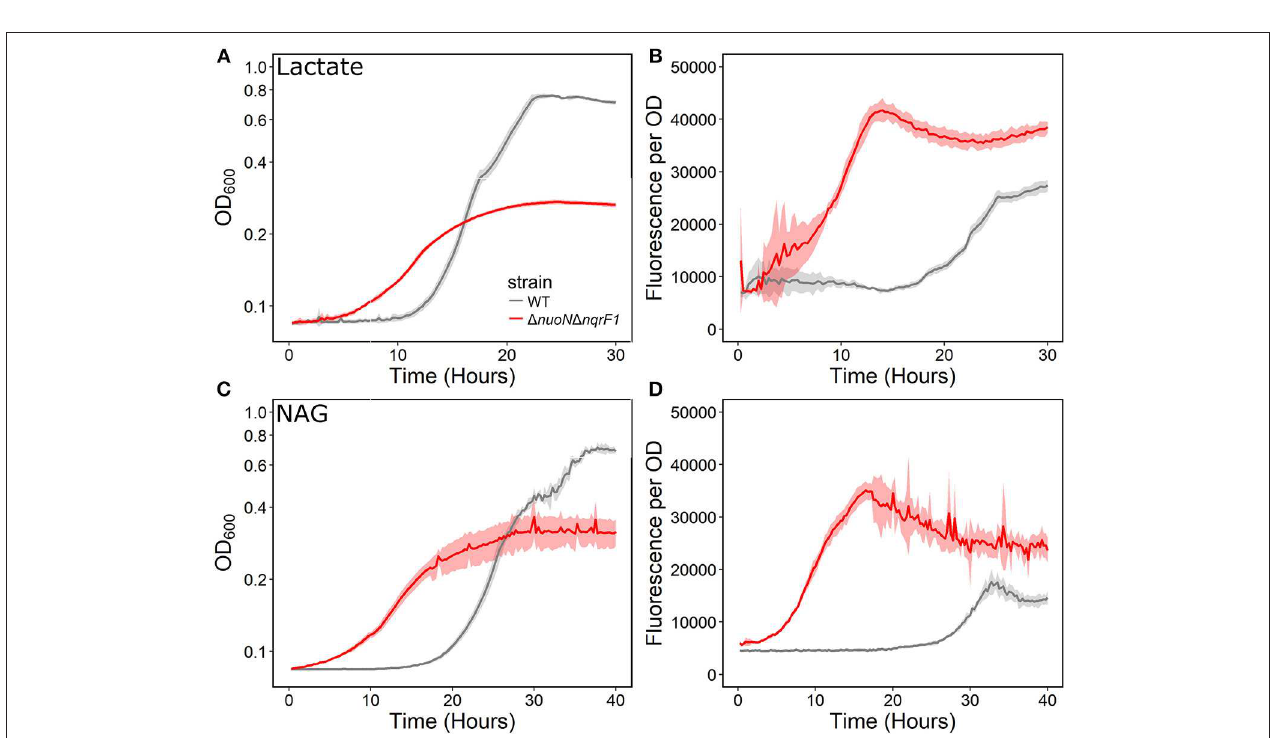
FIGURE 6 | (A) Analysis of growth of the WT and 1 nuoN 1 nqrF1 strains that contain the Rex sensor in 1-mL culture volumes of M5 supplemented with 0.1% tryptone and 20mM D,L- lactate while at 30 ◦ C with shaking. (B) Fluorescence output normalized to OD 600 with D,L -lactate as the substrate. (C) Analysis of growth of the WT and 1 nuoN 1 nqrF1 strains that contain the Rex sensor in 1-mL culture volumes of M5 supplemented with 0.1% tryptone and 10mM NAG . (D) Fluorescence output normalized to OD 600 with NAG as the